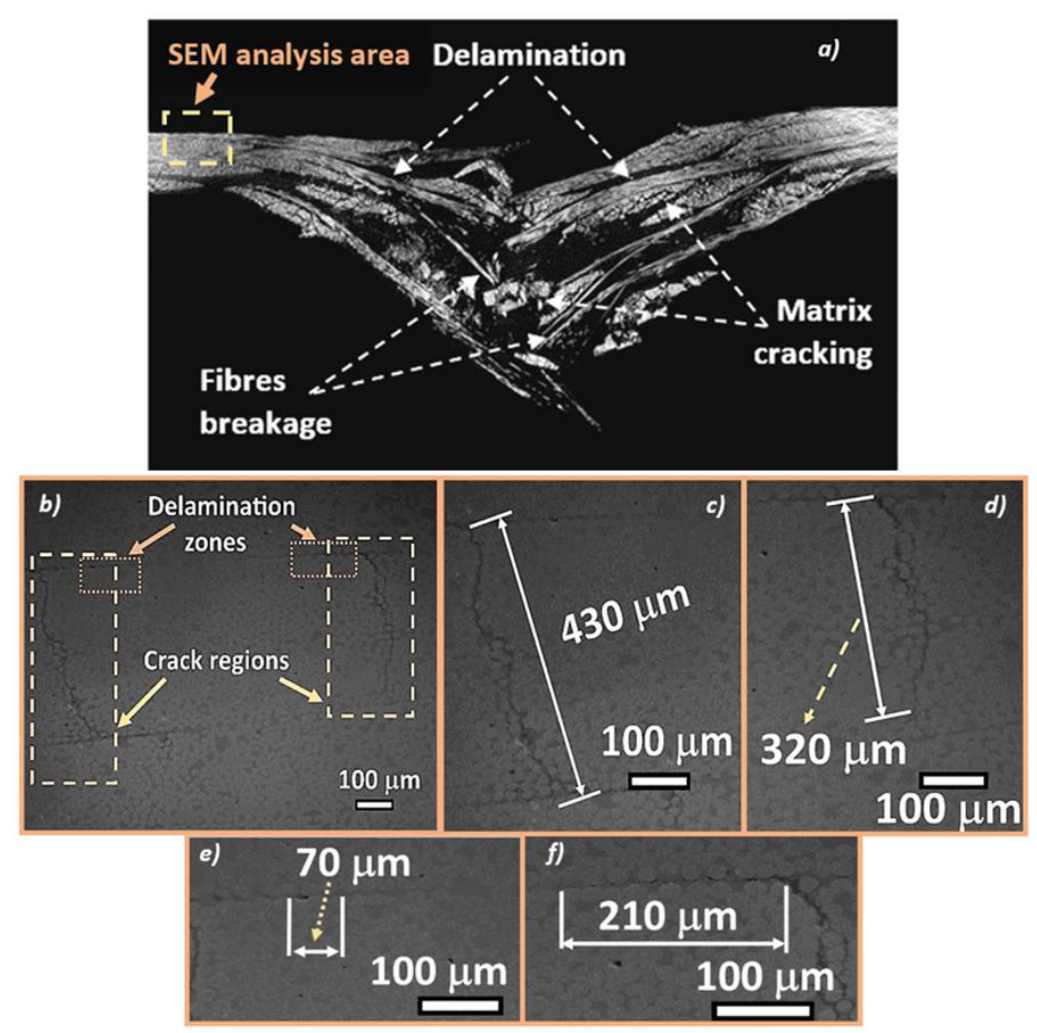
Figure 17. Microtomographic and SEM analysis of the aged GFRE [45°/45°] 4 , impacted at 30 J for: ( a ) general view; ( b, c, d ) intralaminar defects; (e, f) interlaminar debonding.